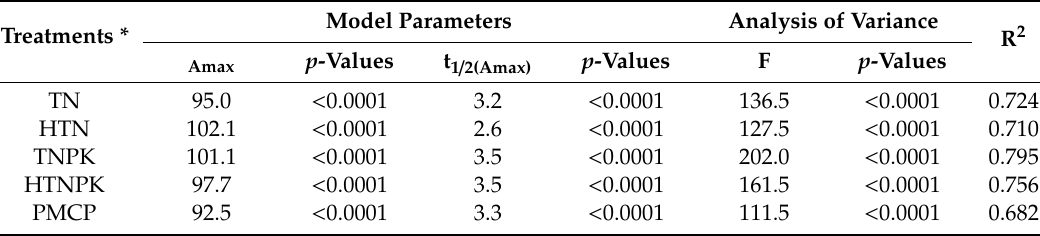
Table 4. Estimation model for NO 3 -N release from di ff erent types of the blended biochar pellet.